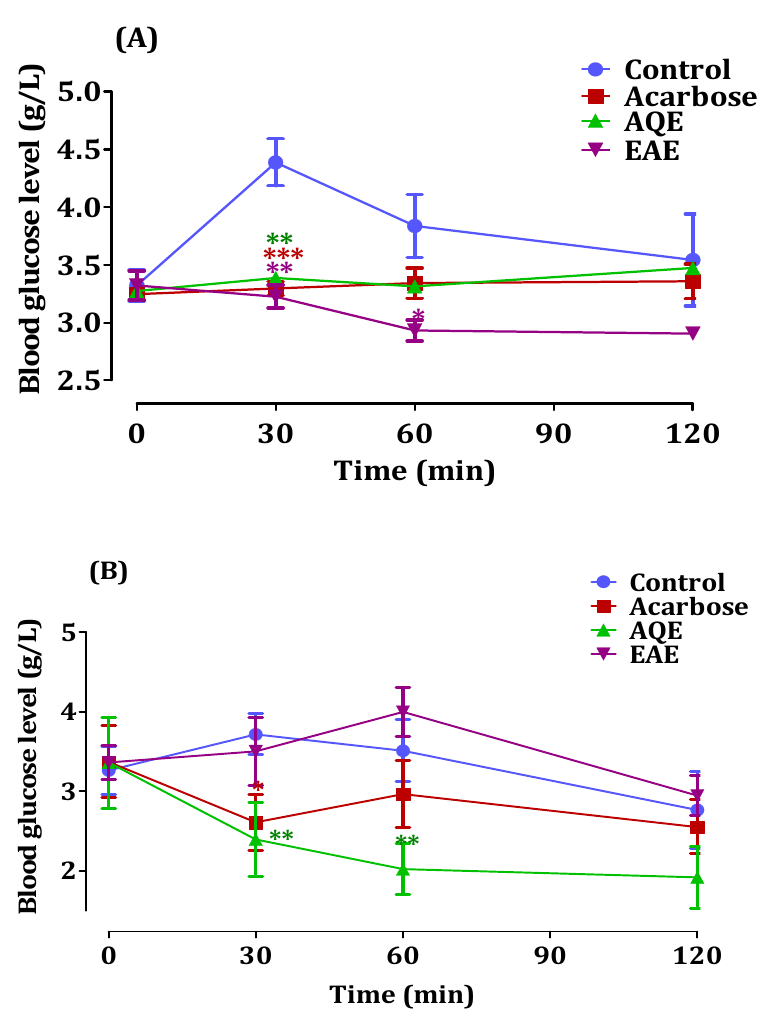
Figure 6. The effects of A. absinthium extracts and acarbose on glycemia in normal rats after starch overload ( A ), and after sucrose overload ( B ) ( n = 5) ((* p < 0.05), (** p < 0.01) and (*** p < 0.001)). The results in Figure 7 correspond to the similar oral starch and sucrose tolerance test conducted previously, but this time on diabetic rats. The effect of A. absinthium extracts on blood glucose after oral starch overload is shown in Figure 7A. The results show that in the presence of EAE, postprandial blood glucose decreased remarkably 30 min after oral starch overload, decreasing to 3.22 and 2.9 g/L at 60 and 120 min, respectively. On the other hand, blood glucose levels increased by 3.67 g/L and 4.52 g/L in the control non-treated group. The group treated with AQE showed a decrease in blood glucose at both 30 and 120 min, with levels of 4.38 and 3.47 g/L, respectively. It can be seen that the blood glucose value in diabetic rats treated with AQE showed similar levels to those treated with acarbose after the oral starch overload; however, EAE showed a remarkably higher hypoglycemic effect than